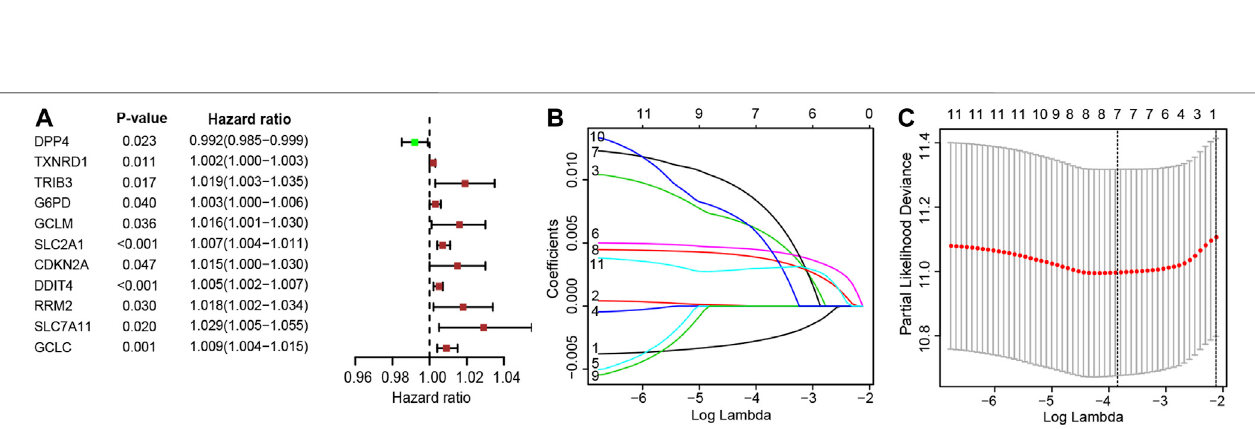
FIGURE 2 | (A) 11 Ferroptosis-related genes signi fi cantly associated with overall survival (OS) in lung adenocarcinoma; (B) Adjustment parameters in LASSO regression model; (C) LASSO coef fi cient spectrum of ferroptosis-related genes.